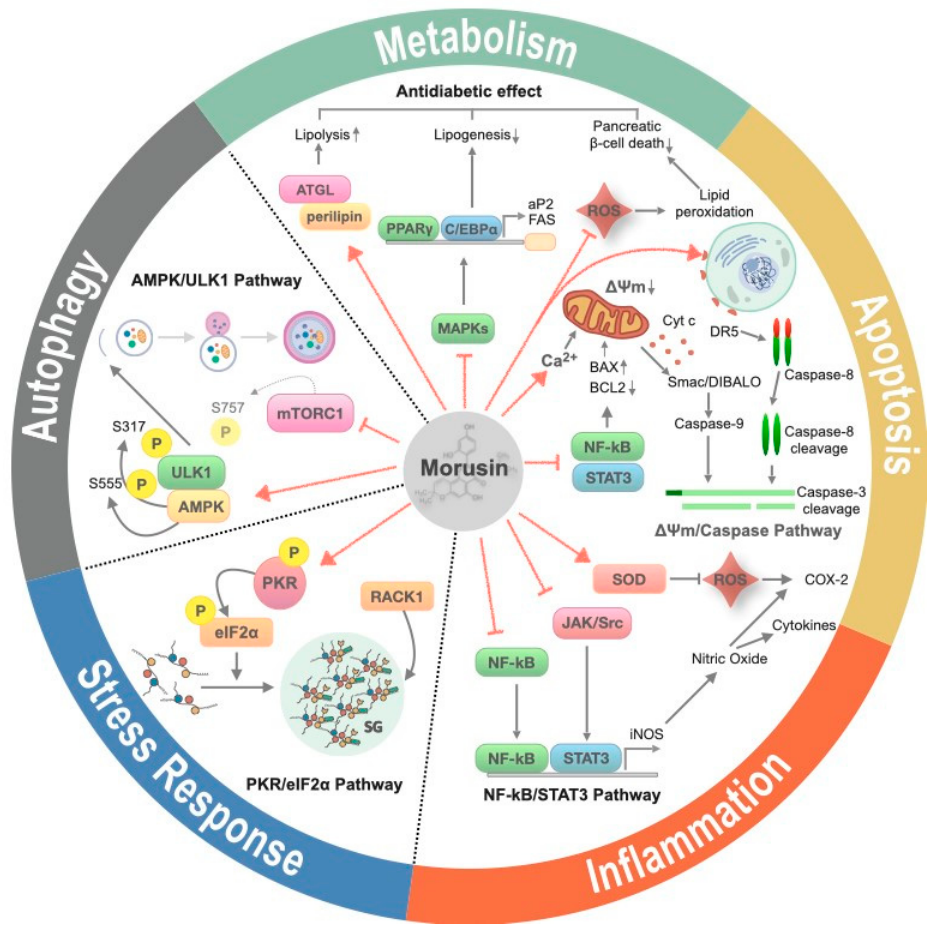
Figure 2. The effects of morusin on cellular processes. Morusin elicits various cellular processes including suppression of inflammation, induction of apoptosis, autophagy and stress granule formation and is involved in the homeostasis of glucose and lipid metabolism. Red solid arrow and solid bar indicates activation and suppression of target molecule, respectively. Upwards and downwards arrow indicates an increase and decrease of target protein or pathway, respectively.